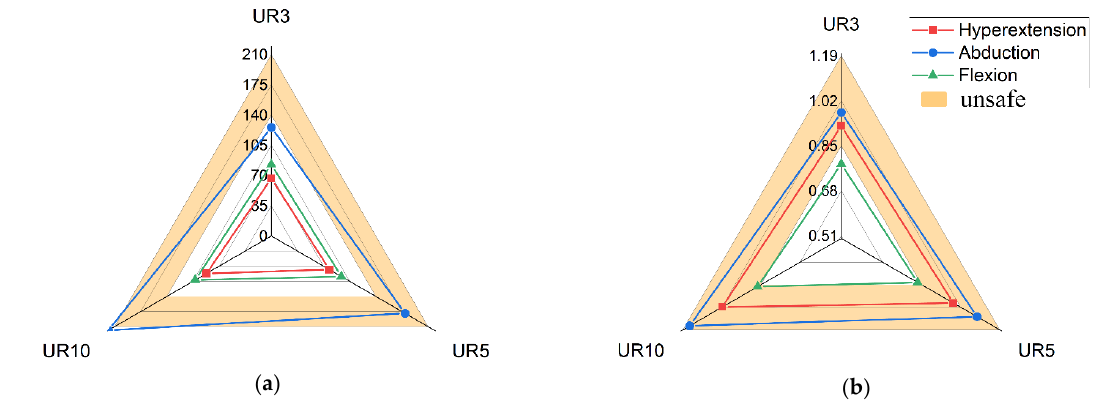
Figure 12. ( a ) Maximum Principal Stress (MPa); ( b ) Maximum Shear Elastic Strain.